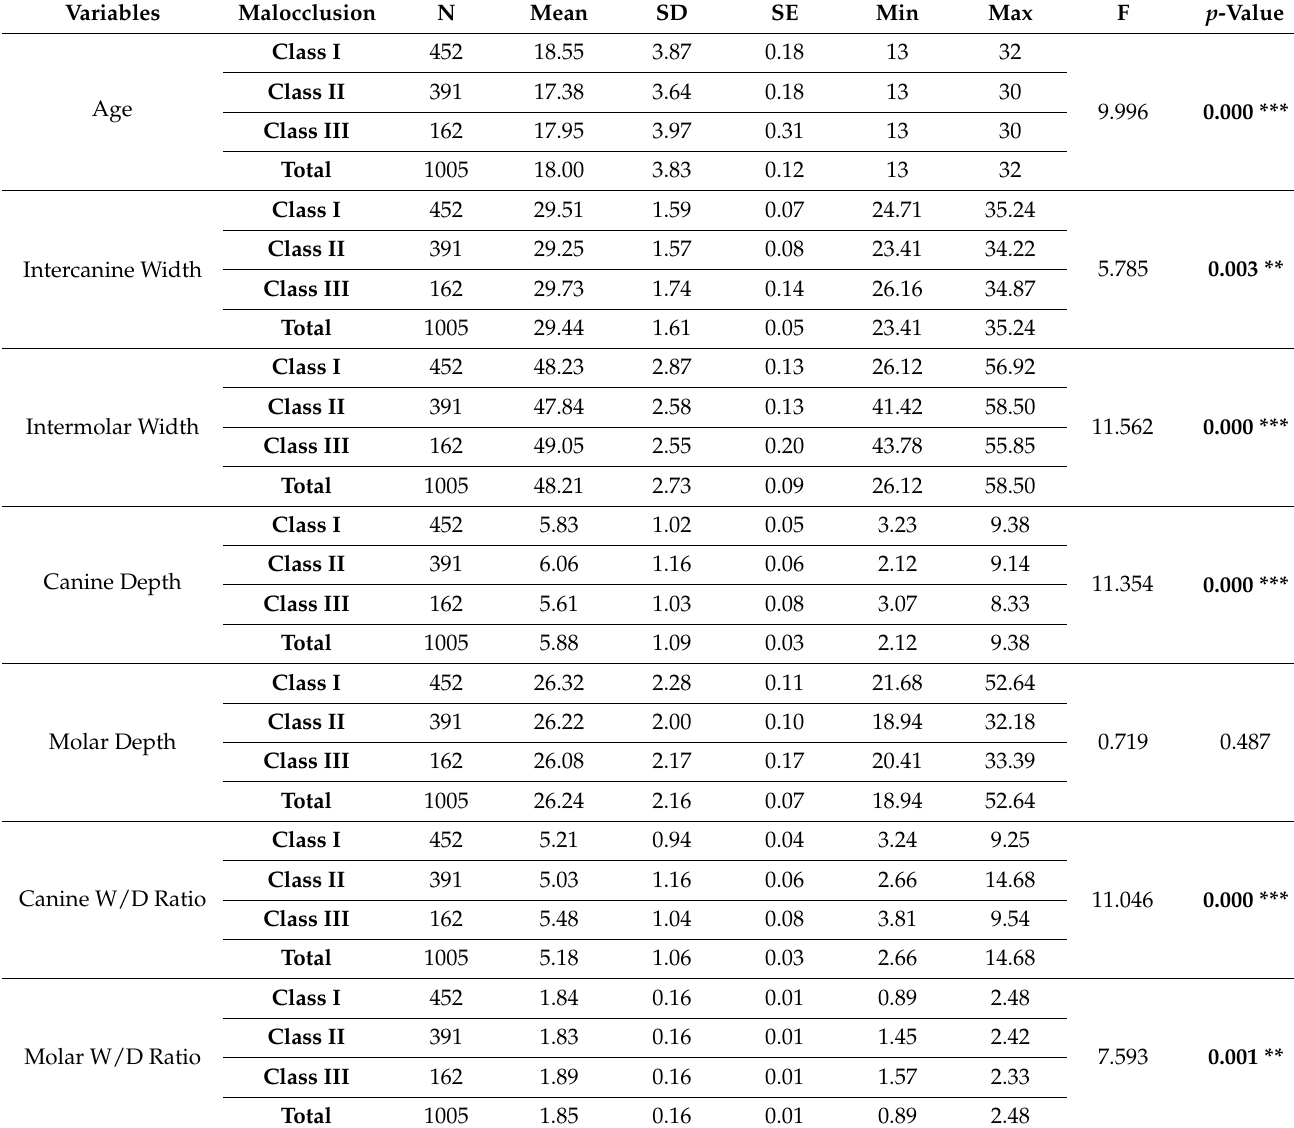
Table 9. Descriptive statistics and comparison of age and arch dimensions among malocclusions (ANOVA test).